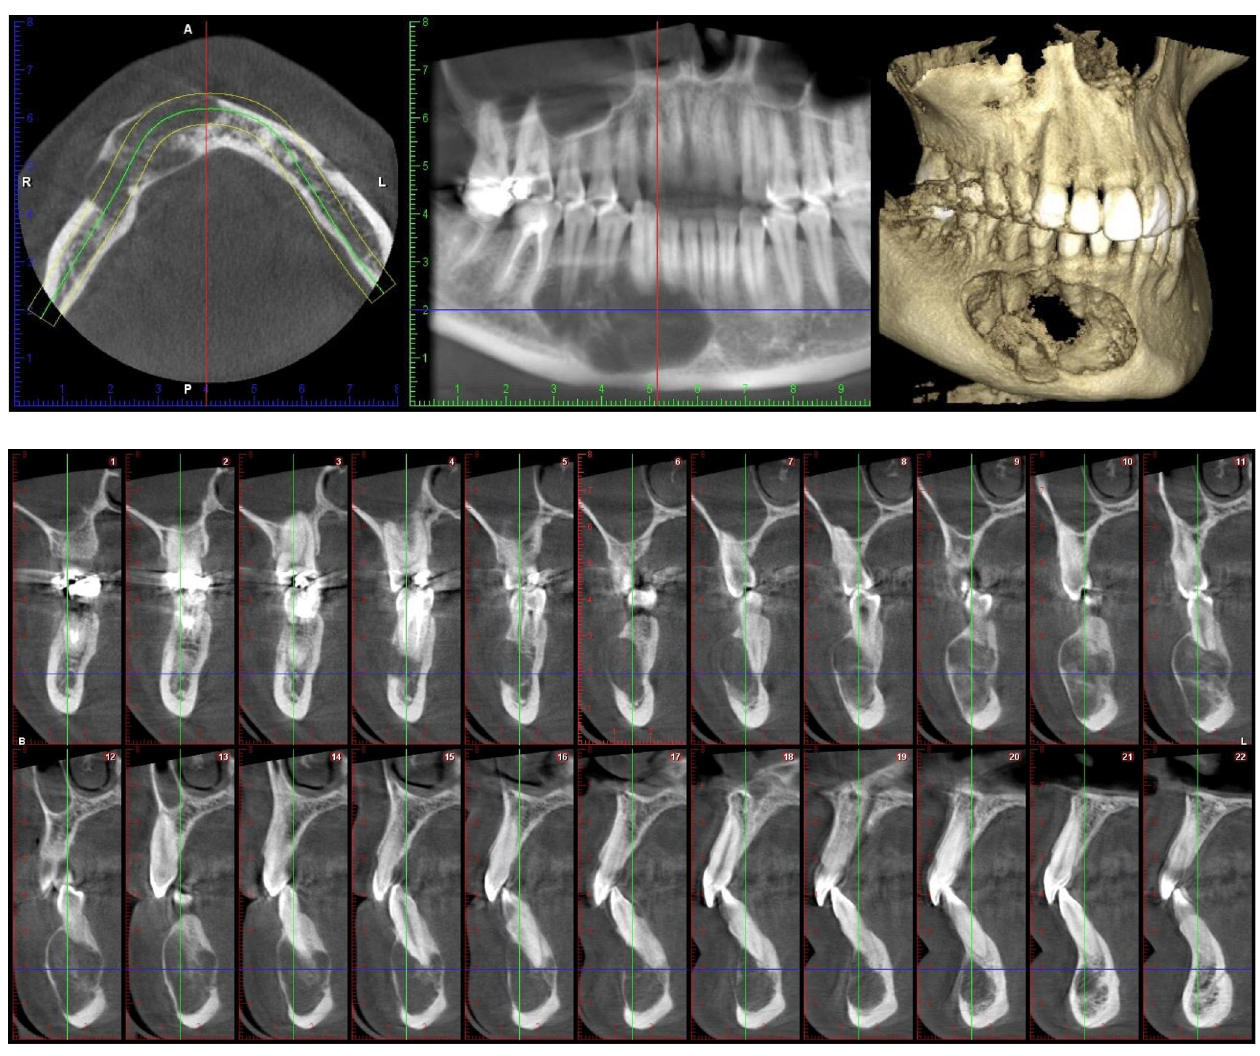
Figs. 2 and 3. Axial and curvilinear section and 3D representation of right mandibular substance